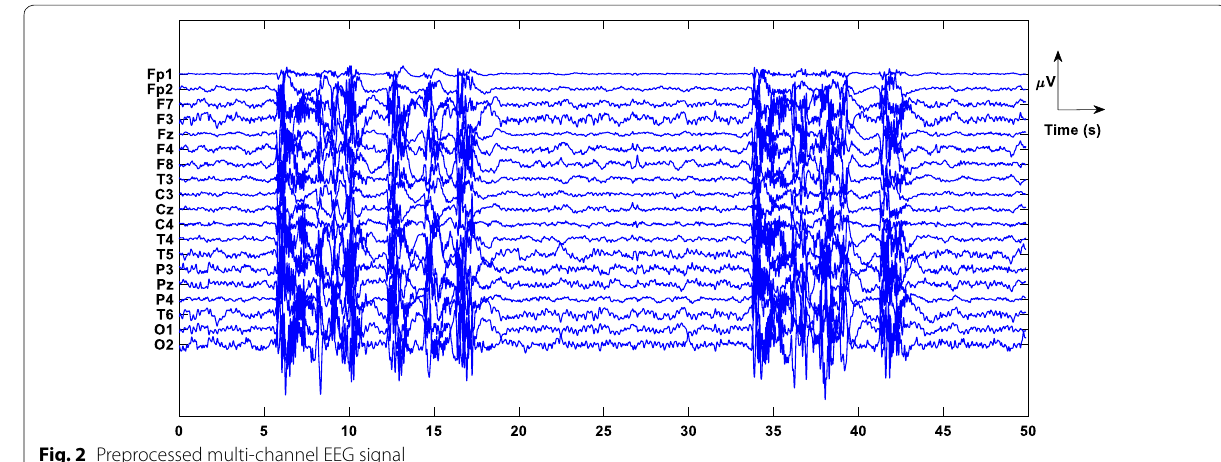
Fig. 2 Preprocessed multi-channel EEG signal